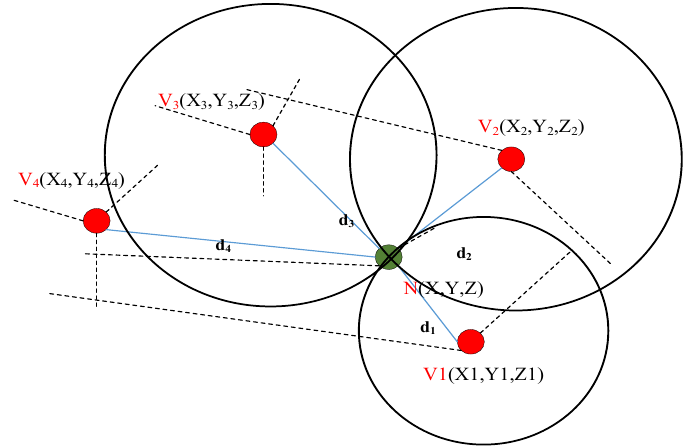
Figure 2. Trilateration in 3D based